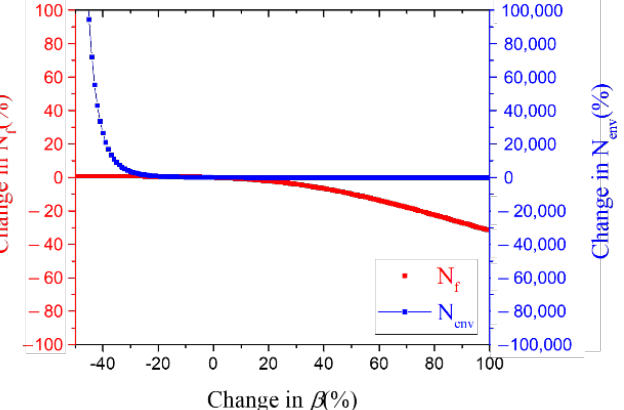
Figure 10. Fatigue life according to oxidation-induced rate exponent, β changes based on sensitivity analysis.